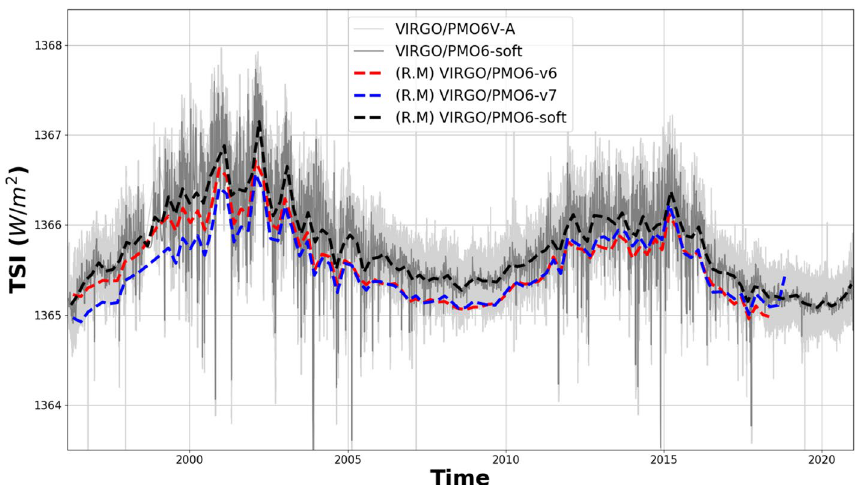
Figure 3. The degradation-corrected PMO6-VA time series (light grey), the fused PMO6-VA and -VB (PMO6-soft, dark grey) and the previous versions of the VIRGO/PMO6 degradation corrected TSI time series (PMO6-v6 (red), PMO6-v7 (blue)). The dashed lines are 81-day running means (R.M.).